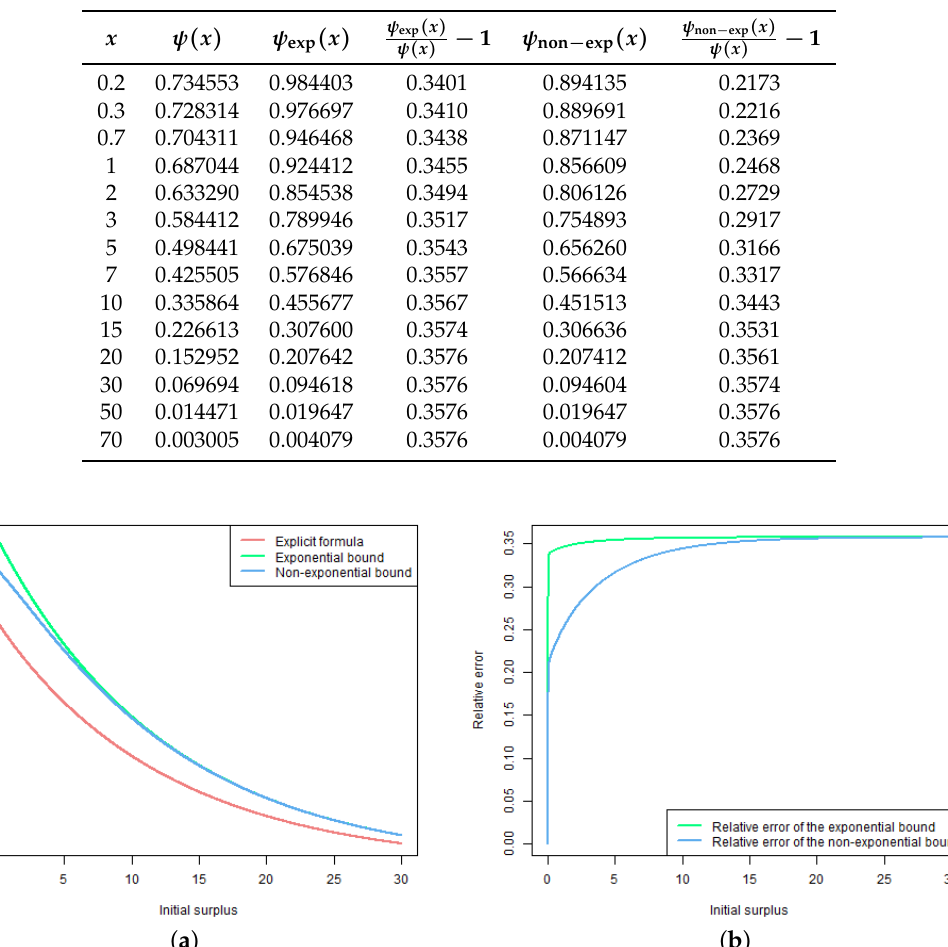
Table 4. Results of computations for the model considered in Example 4.